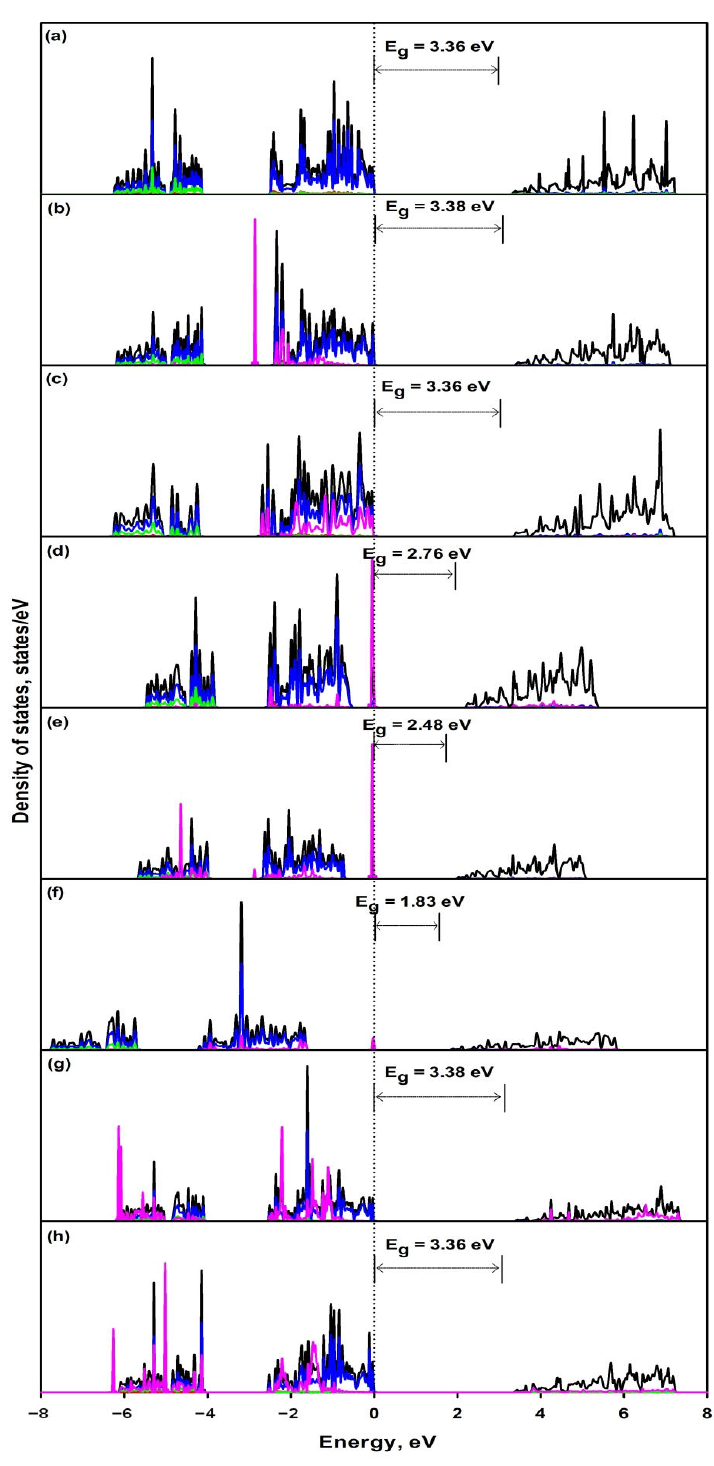
Figure 3. Total and partial DOS (PBE) of various 2D Mg(OH) 2 including ( a ) pristine ( b ) F, ( c ) Cl, ( d ) S, ( e ) N, ( f ) P, ( g ) SO 4 , ( h ) PO 4 . The Fermi level is set as zero energy. The black line stands for TDOS, while the red, blue, green and pink lines stand for contribution of Mg atoms, O atoms, H atoms and dopant, respectively.